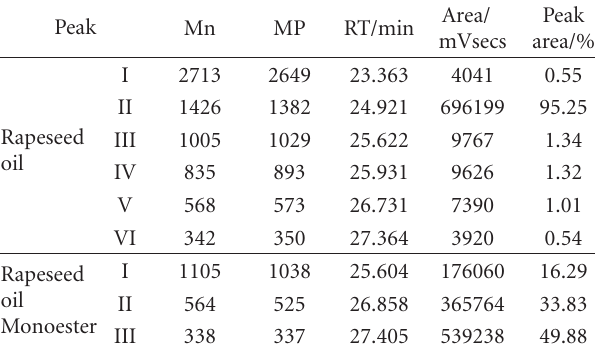
Figure 1: IR spectrum of rapeseed oil after pretreatment.